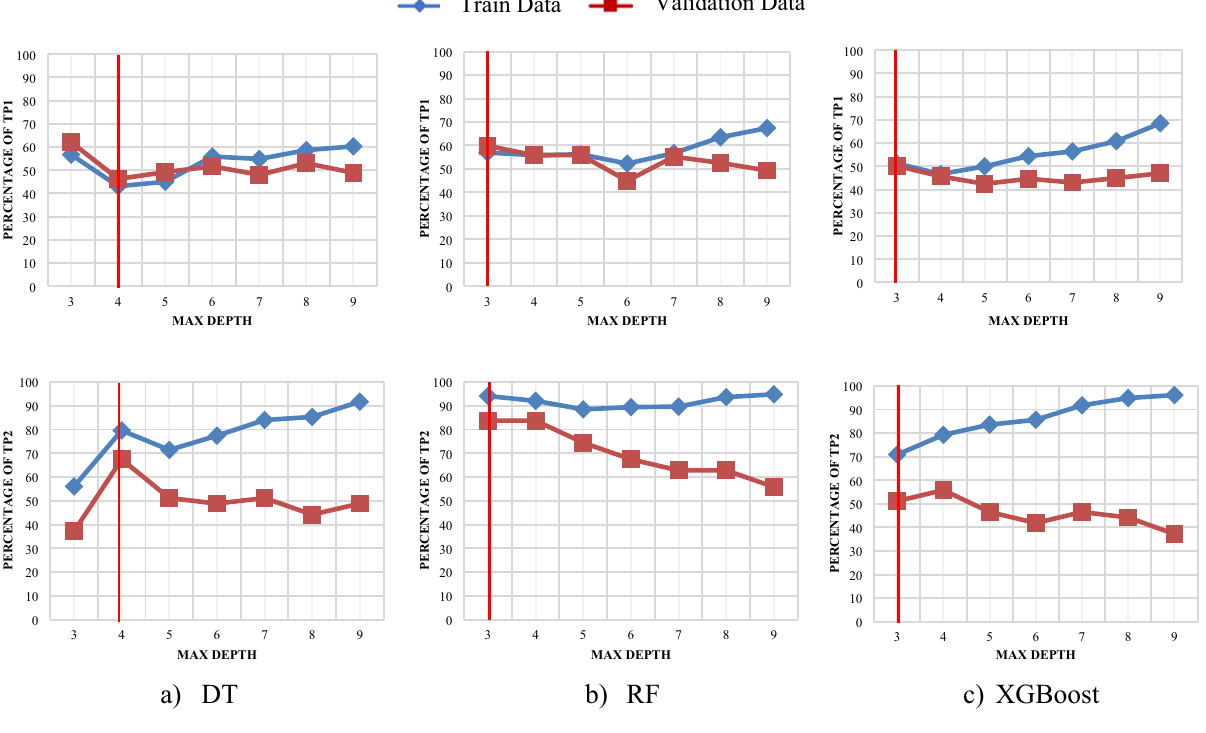
Figure 5. Maximum depth selection for different DT